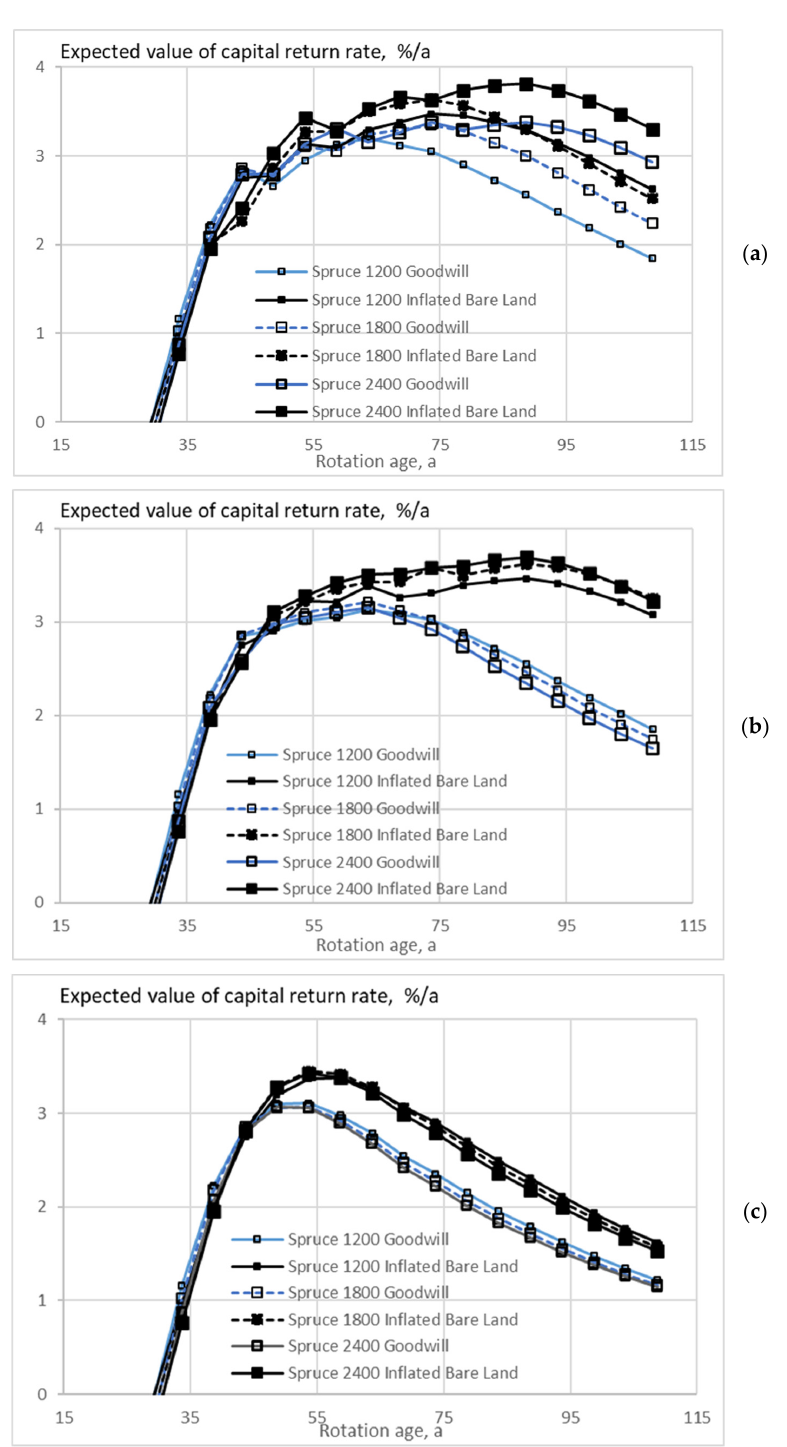
Figure 4. The expected value of capital return rate on spruce stands of different initial sapling densities, as a function of rotation age, when the growth model is applied as early as applicable, without any thinning restriction ( a ), in good-quality trees of at least 238 mm of diameter only removed in thinning ( b ), and without commercial thinning ( c ). Inflated capitalization is introduced either as proportional goodwill or as inflated bare land